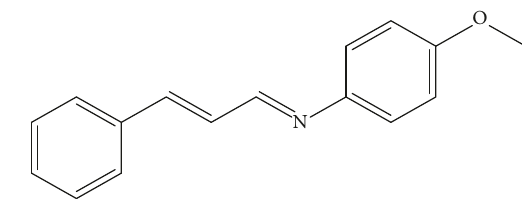
Figure 1: Structure of the monodentate Schiff base (4-methox-